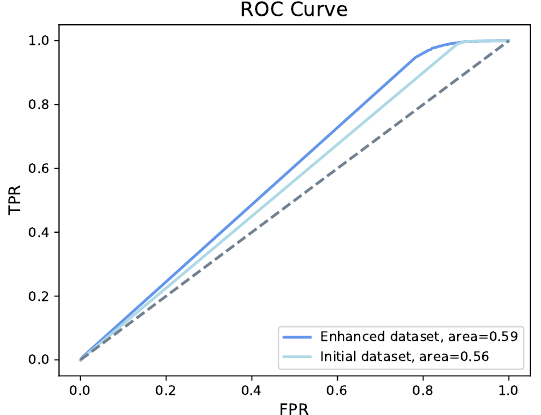
Figure 8. ROC of MLP. MLP shows an accuracy of 98% on both the initial and the enhanced structured dataset, with an increase in area under the curve from 56% to 59%.